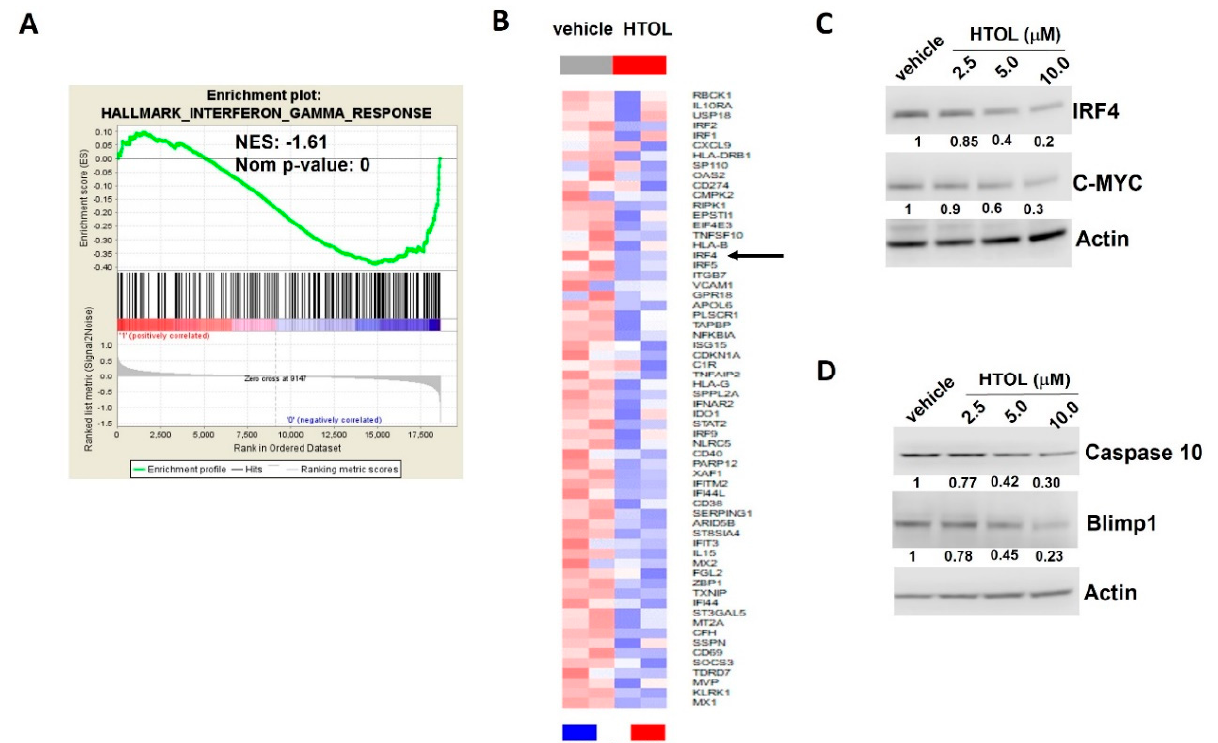
Figure 3. HTOL inhibits the IRF4 pathway. ( A ) GSEA performed 24 h after treatment of JJN3 cells with 5.0 μ M HTOL shows a decrease in IFN- γ genes in JJN3 cells. ( B ) Heatmap analysis reporting the core enrichment genes of the IFN- γ pathway, also including IRF4, found them to be significantly down-regulated after 5.0 μ M HTOL treatment of JJN3 cells. WB of ( C ) IRF4, c-MYC, ( D ) caspase-10 and Blimp1 in JJN3 cells exposed for 24 h to HTOL treatment; actin was used as loading control.